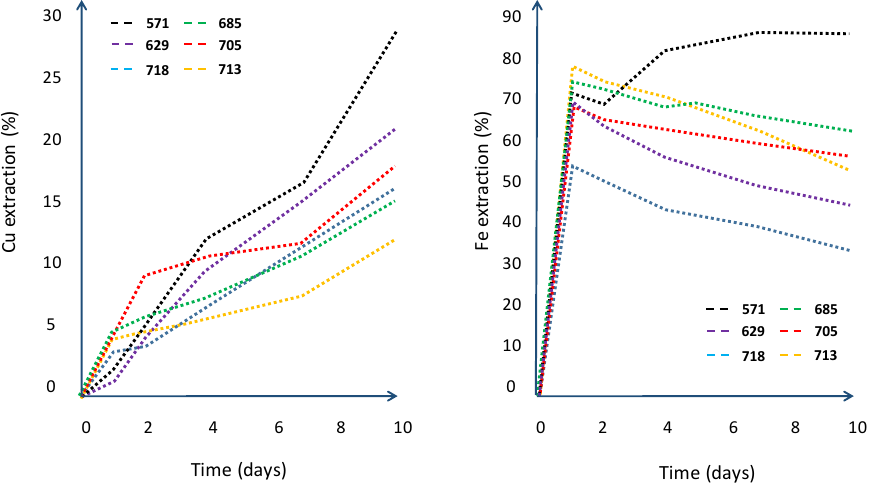
Figure 10. Copper and iron extraction in 25 g/L [Fe 3+ /Fe 2+ ], 10 g/L [Al 3+ ], 1 g/L [Mg 2+ ], 0.2 g/L [Cu 2+ ], 125 g/L [SO 4 2 − ], pH of 1.2, and temperature of 50 °C at different Eh (Modified from [10]).